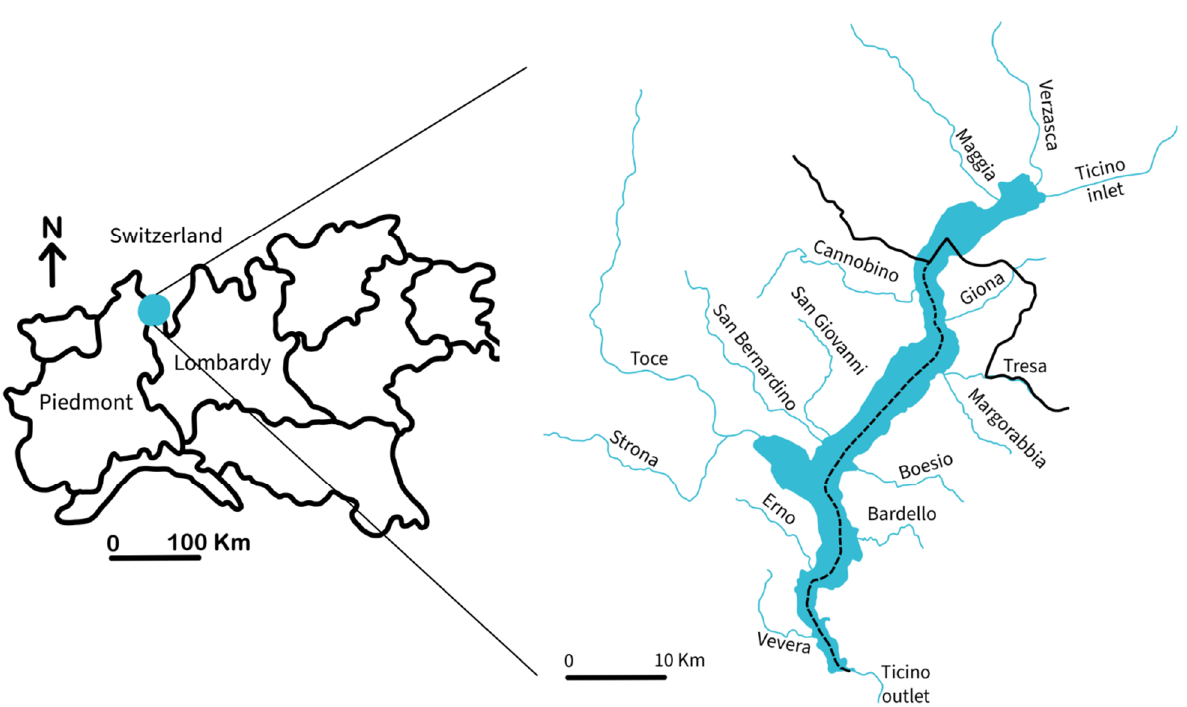
Figure 1. Study area: Lake Maggiore and its main tributaries. Dotted line: border between Lombardy and Piedmont regions; solid line: border between Italy and Switzerland.